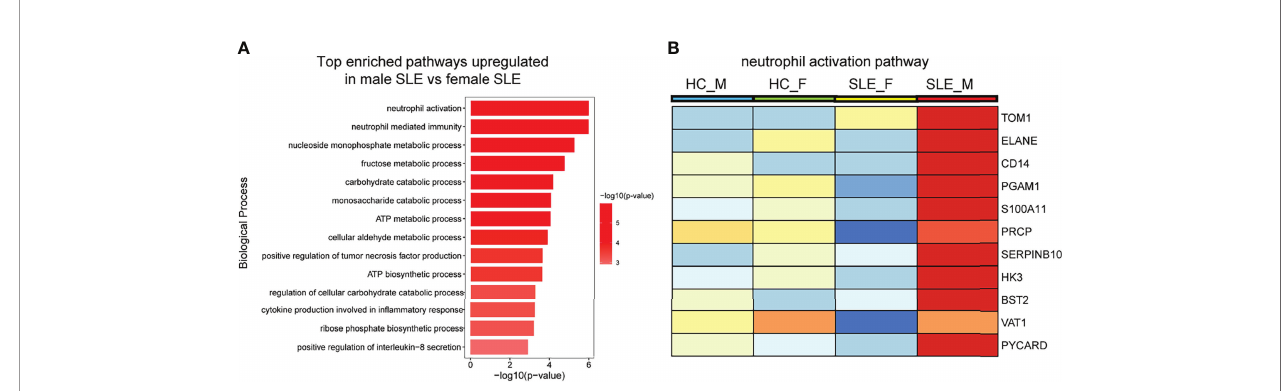
FIGURE 5 | Neutrophil activation works is more prominent in male SLE relative to female SLE. (A) Bar plot showing top enriched pathways upregulated in male SLE versus female SLE. (B) Heatmap showing the expression of core proteins that contribute to neutrophil activation pathway enrichment (red, high abundance; blue, low abundance). HC_F, female healthy control; HC_M, male healthy control; SLE_F, female SLE; SLE_M, male